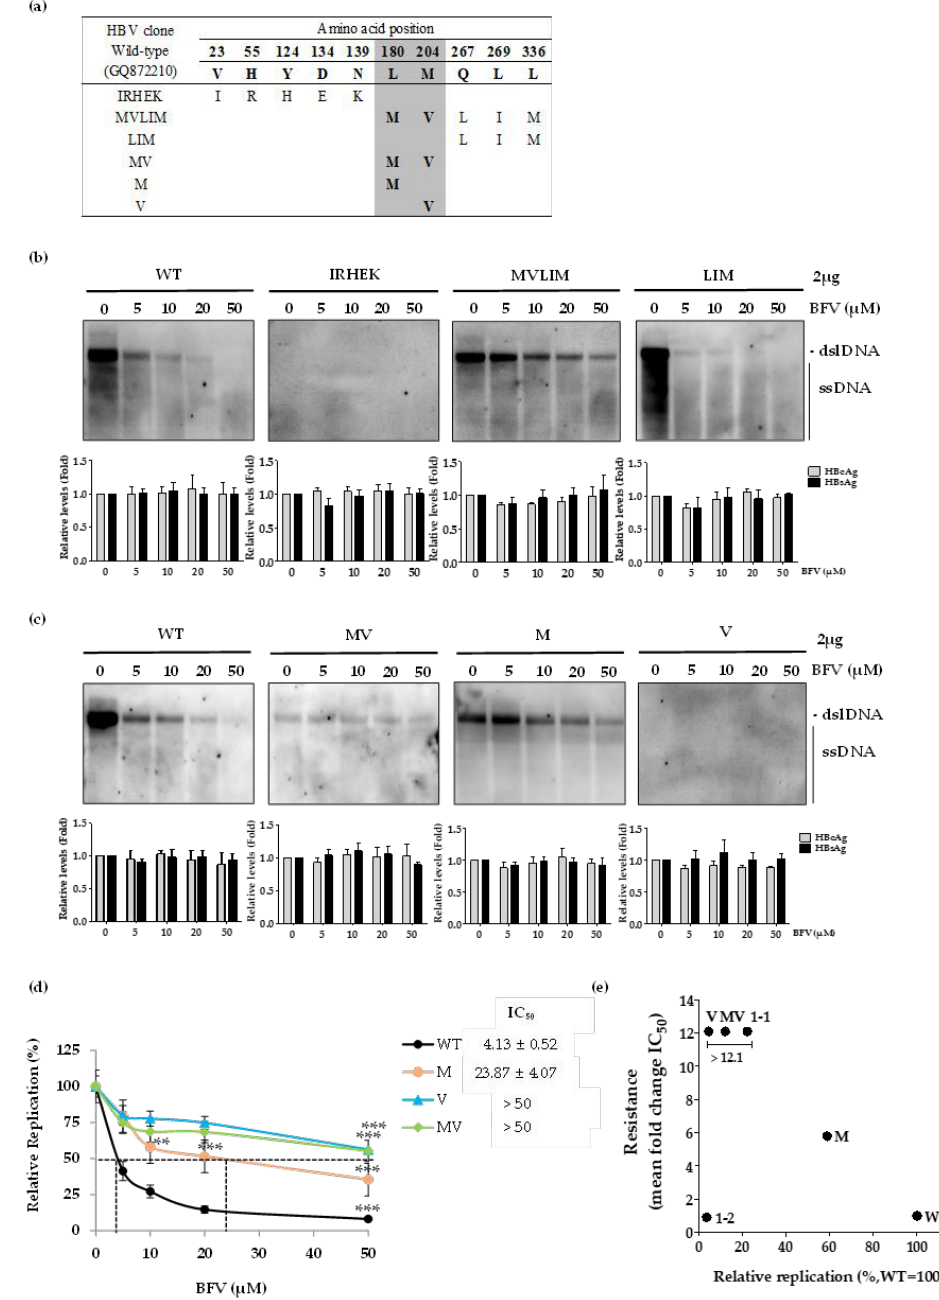
Figure 3. Identification of BFV-resistant mutation in patient-derived HBV mutant. ( a ) The sequences of patient-derived and artificial replicons constructed in this study are compared with that of WT. ( b , c ) The constructed HBV 1.2mer replicons were transfected into Huh7 cells, and BFV was treated every day in a dose-dependent manner as indicated. At 5 h post-transfection, BFV was treated for 3 days. The level of HBV DNA and secreted antigen were determined Southern blot and ELISA, respectively. ELISA was performed to confirm the transfection yield. ( d ) IC 50 values were measured by quantitative real-time PCR. ** p < 0.01; *** p < 0.001. The level of HBV replication without drug treatment was set to 100 %. ( e ) Replication ability and BFV resistance of each clone were compared with WT through real-time PCR. All data were obtained from at least 3 independent experiments (mean ±